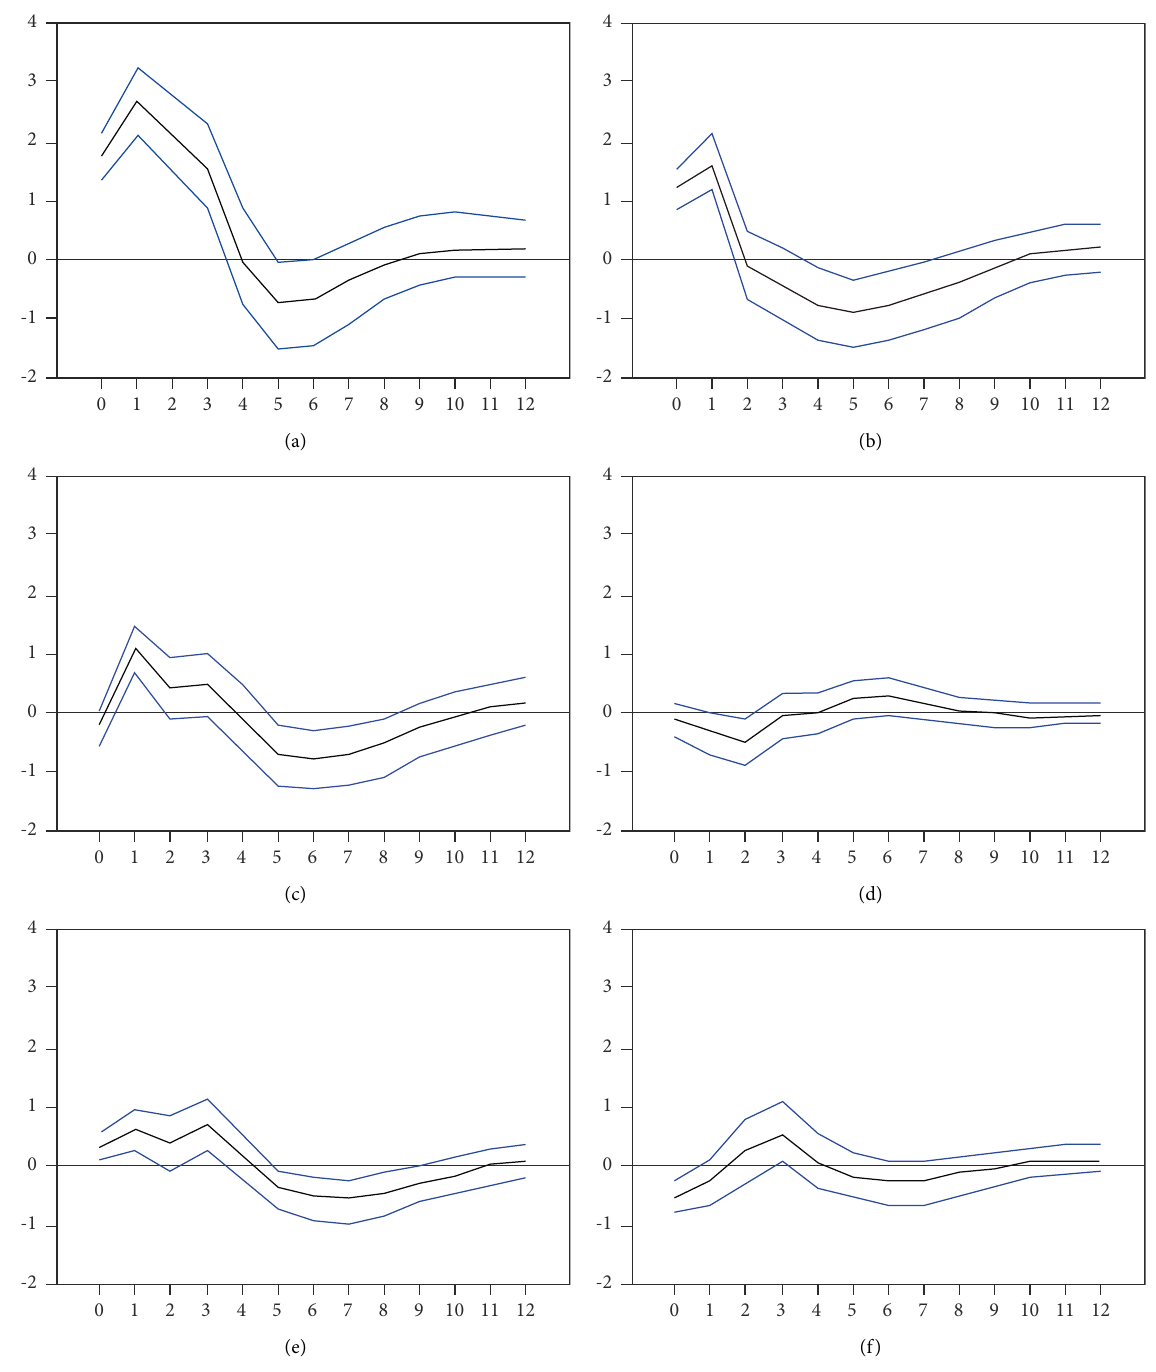
Figure 3: Impulse response function (IRF) of the seaborne freight volume. (a) Foreign real economic shocks. (b) Foreign infation shocks. (c) Foreign liquidity shocks. (d) Foreign rates shock. (e) Domestic GDP shocks. (f) Import-export trade volume shocks. Note: the blue line represents the 90% confdence interval. Te unit of the vertical line is %